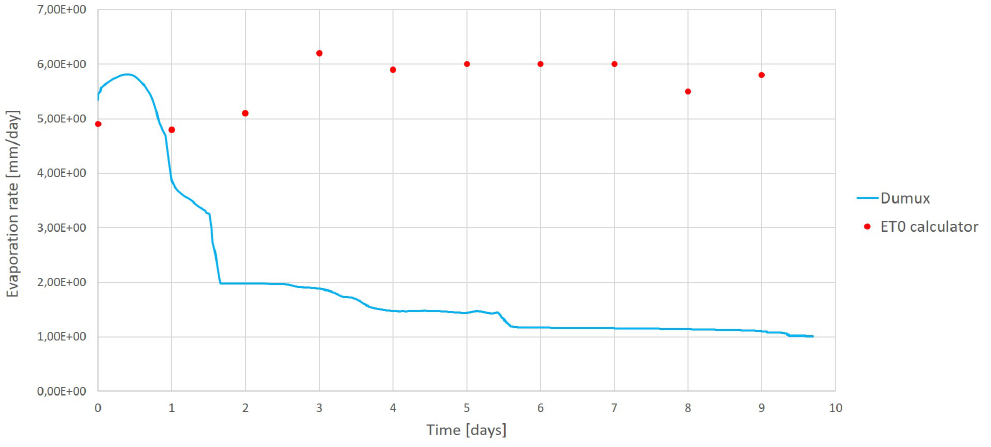
Figure 16. Variations of the evaporation rate obtained from Dumux simulations and from ET0 calculator.